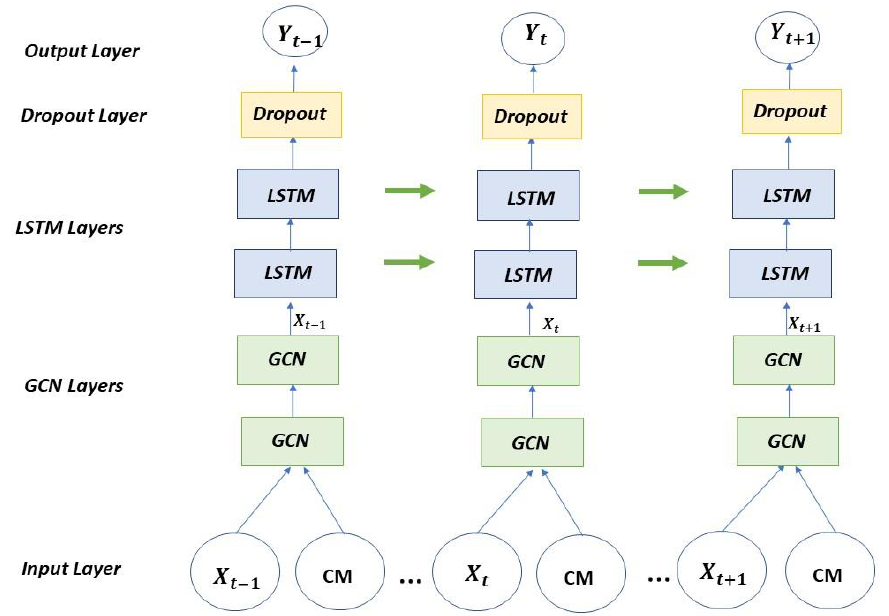
Figure 3. GCN-LSTM Figure 3. GCN-LSTM Model.